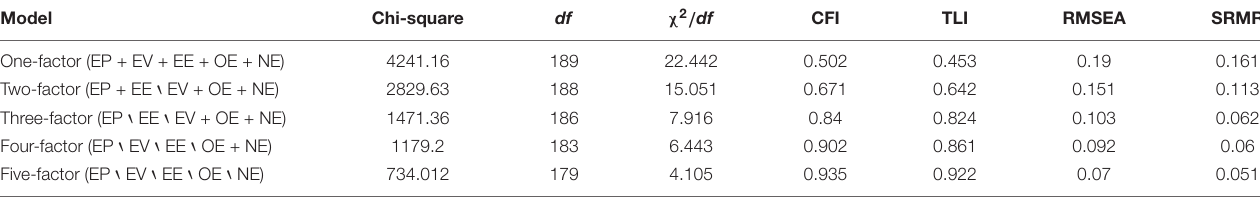
TABLE 1 | Confirmatory factor analysis results of discriminant validity of variables. Model